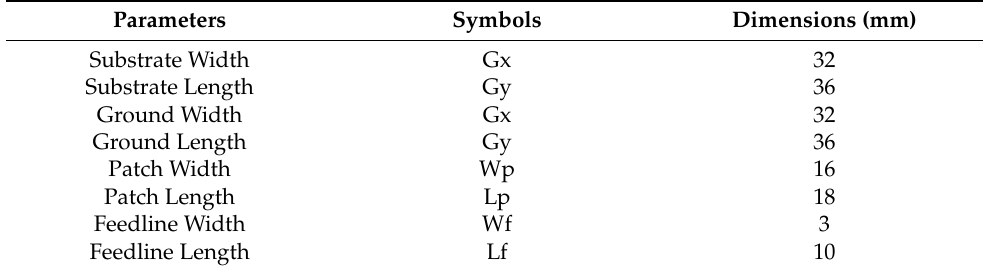
Figure 3. ( a ) Rectangular patch antenna design with single V − shaped extrudes; ( b ) Rectangular patch antenna design with two V-shaped extrudes.